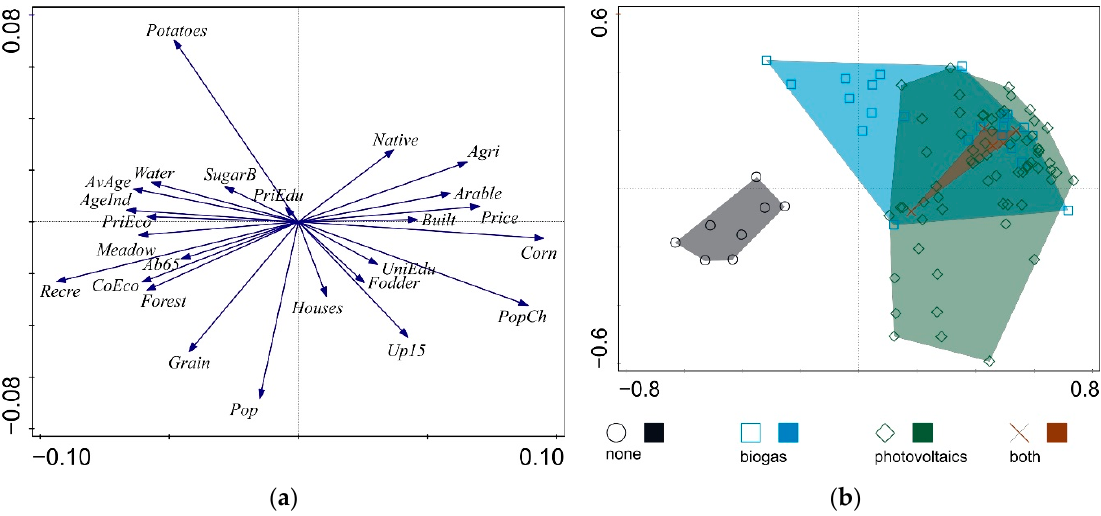
Figure 8. ( a ) Ties among significant characteristics of communities in two-dimensional RDA space; ( b ) Position of four types of communities under investigation in the same space.